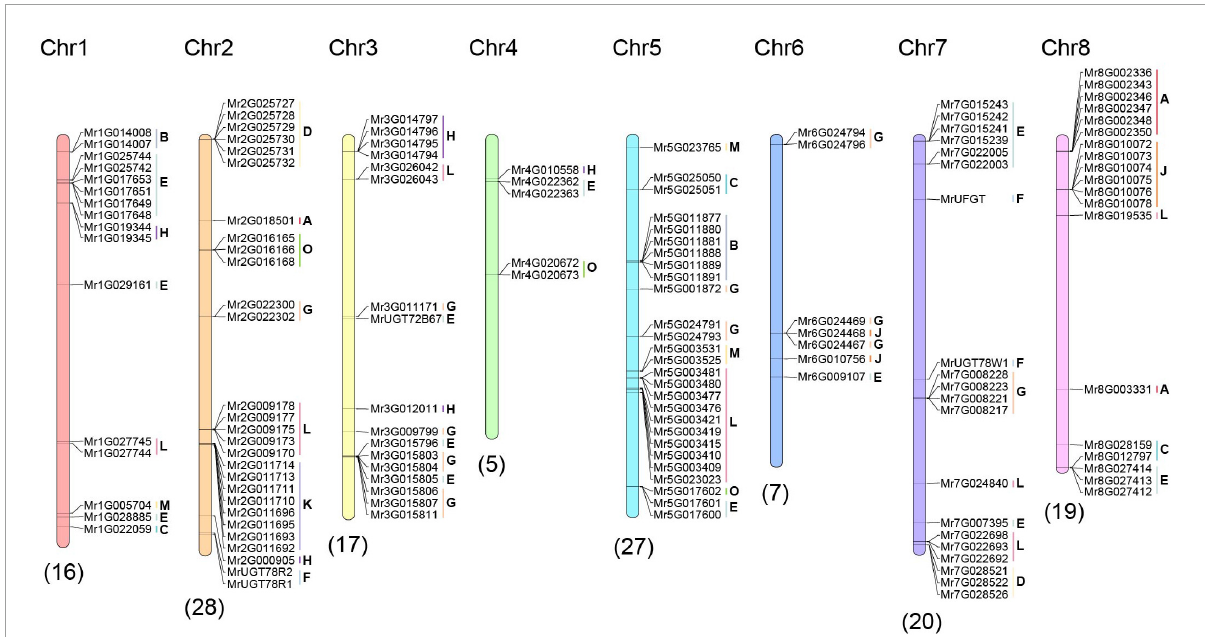
FIGURE3 Chromosome distribution of MrUGT genes. Numbers of chromosomes were labeled at the top of each chromosome. Numbers of MrUGT s on chromosome were labeled at the bottom of each chromosome. Group of MrUGT s is labeled next to MrUGT accession numbers.